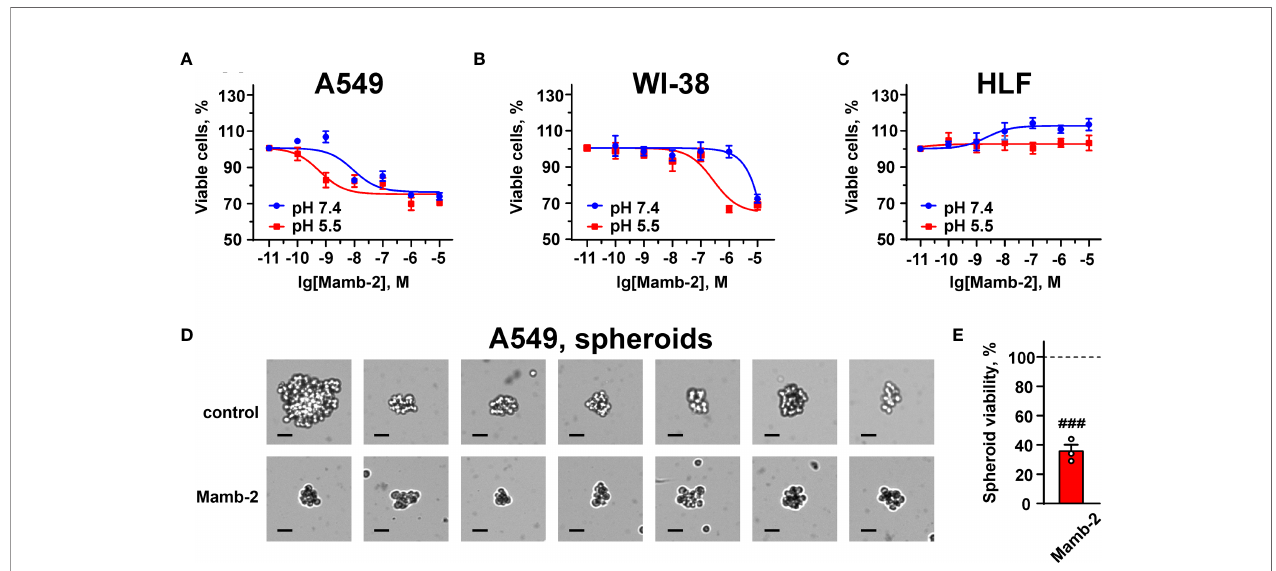
FIGURE 1 | Dose – response effects of mambalgin-2 on viability of A549 (A, D, E) , WI-38 (B) , and HLF (C) cells. (A – C) Cells were cultured at pH 7.4 and at pH 5.5. Data are presented as % of the control (untreated cells) ± SEM (n = 4). (D) Examples of the spheroids reconstructed from A549 cells incubated in the absence or presence of 1 µM of mambalgin-2 after staining by Trypan Blue, scale bar = 25 µm. (E) In fl uence of 1 µM of mambalgin-2 on the viability of the spheroids reconstructed from A549 cells. Data are presented as % of the control (untreated spheroids) ± SEM (n = 3). ### (p < 0.001) indicates difference between untreated and treated spheroids according to one-sample